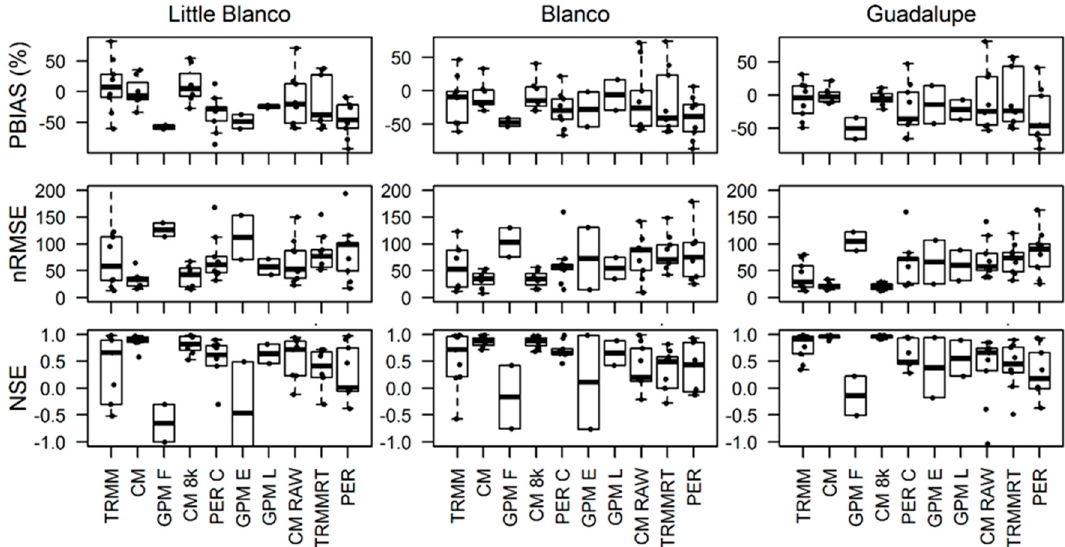
Figure 4. Boxplots for hyetograph performance statistics for all spatial domains. X -axis labels are abbreviated as follows: TRMM—TRMM 3B42, CM—CMORPH CDR, GPM F—GPM IMERG FINAL, CM 8K—CMORPH 8KM, PER C—PERSIANN CCS, GPM E—GPM IMERG EARLY, GPM L—GPM IMERG LATE, CM RAW—CMORPH RAW, TRMM-RT—TRMM-RT 3B42, and PER—PERSIANN. Boxplots display the lower and upper quartiles and median. Whiskers extend to the data point nearest ± 1.5 * interquartile range. Table 3. Satellite hyetograph performance statistics aggregated across the three spatial domains. Gauge Correction No Gauge Correction